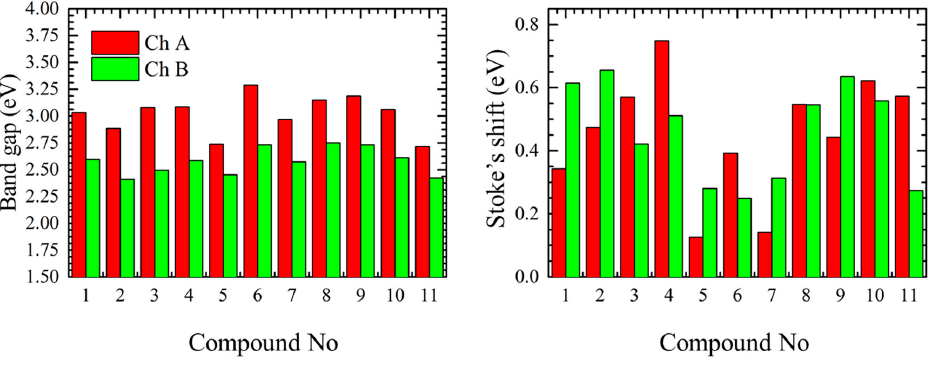
Figure 3. Optically measured bandgap and Stoke’s shift values for the compounds 1 – 11 .